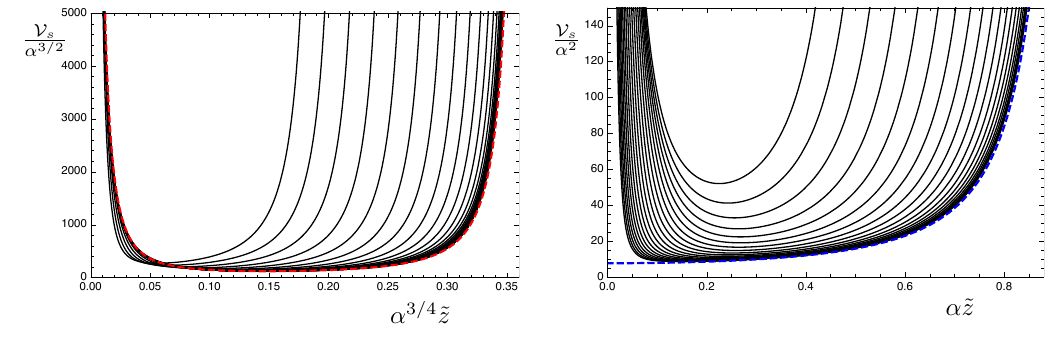
Figure 5 . The Schr(cid:127)odinger potential for a few di(cid:11)erent values of (cid:28) B OP (red) and B conf 8 8